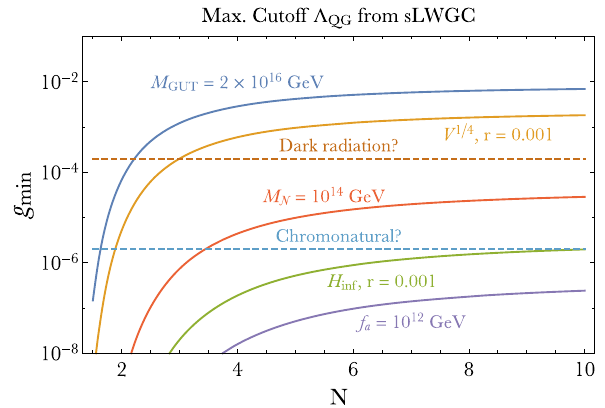
Fig. 4 (s)LWGC UV cutoff bound as a function of g and N (solid con- tours, labeled by representative physical scenarios). The dashed lines are benchmark choices of g in two particular cosmological scenarios that favor small nonabelian gauge